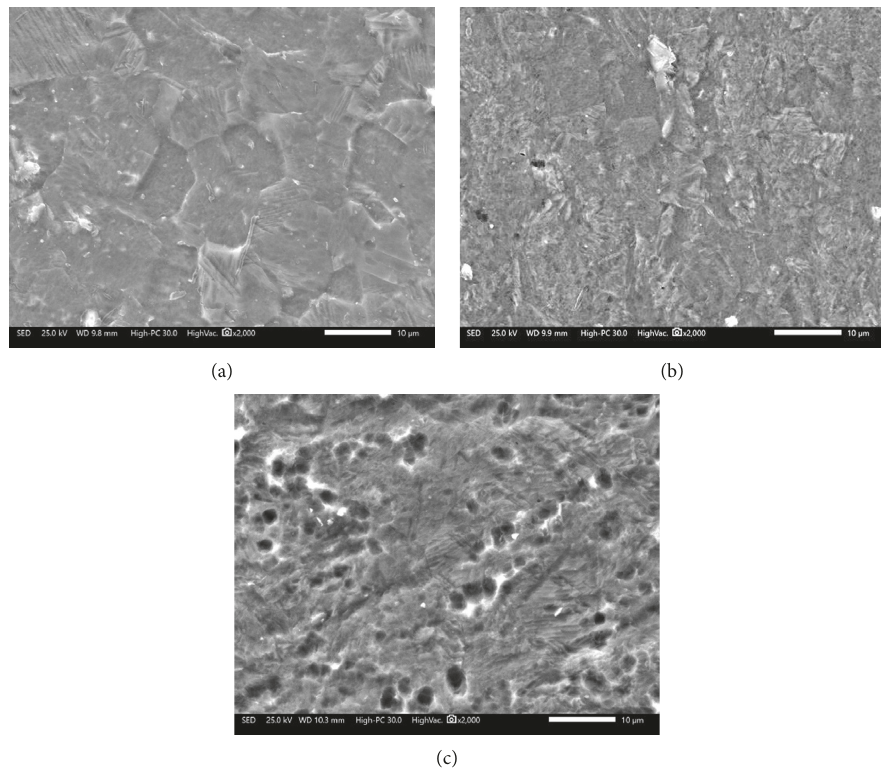
Figure 6: Microstructural characteristics of nonalloyed Ti biomaterials: (a) Switzerland; (b) Mexico; (c) Ti